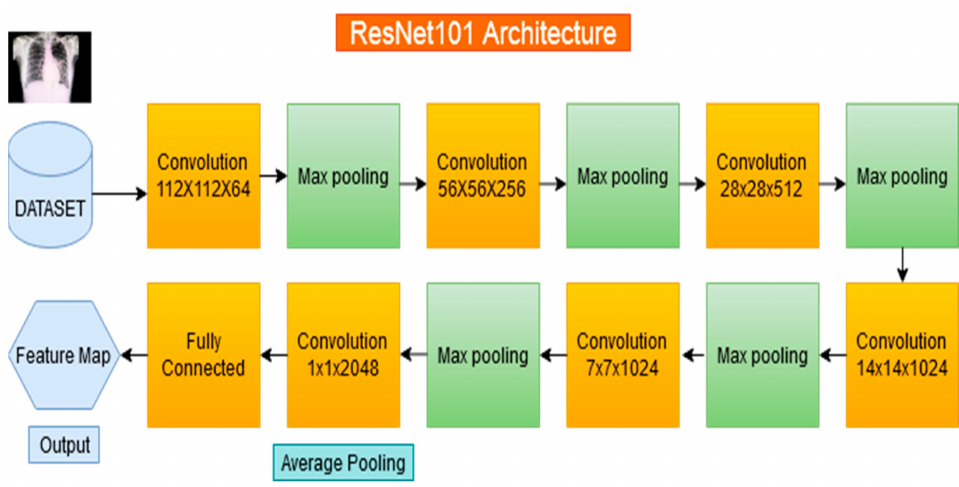
Figure 4. ResNet101